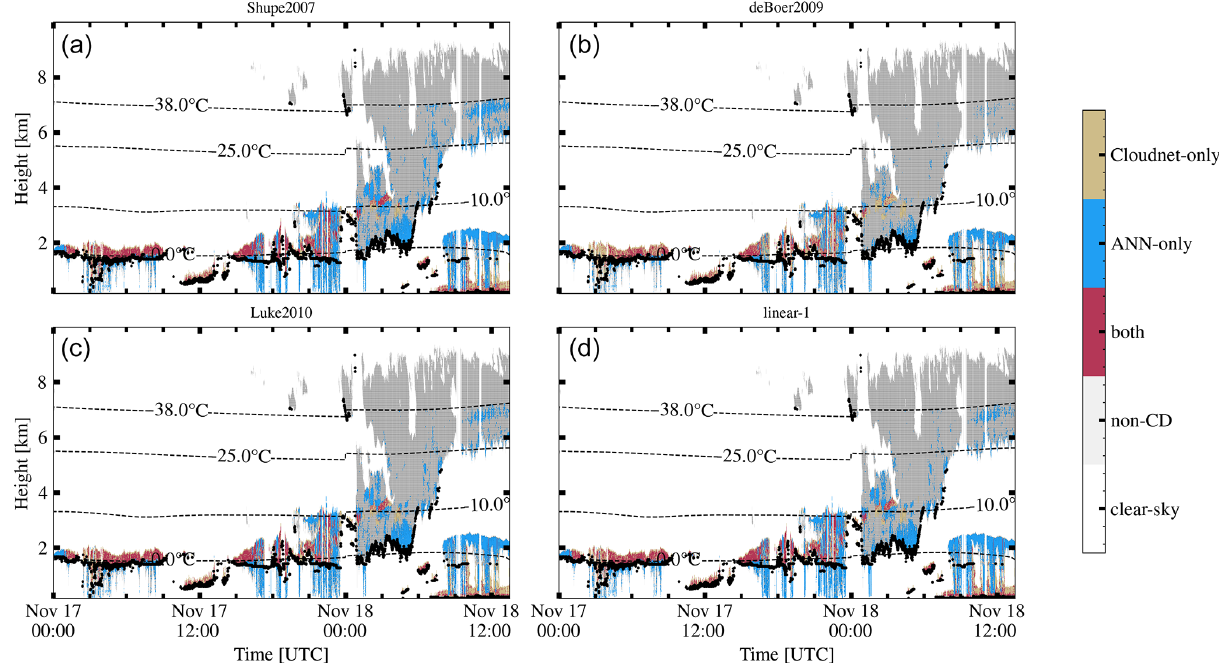
Figure 3. Sensitivity study of liquid pixel classifications of the 17–18 November 2014 case study using liquid mask thresholds of Shupe2007 (a) , deBoer2009 (b) , Luke2010 (c) , and linear-1 (d) on the ANN-predicted lidar variables. Light brown: Cloudnet-only liq- uid classifications, blue: ANN-predicted pixels using the given thresholds which were not classified as liquid droplets by Cloudnet, red: pixels classified as liquid by the ANN and Cloudnet, grey shading: pixels for which neither Cloudnet nor the ANN classified cloud droplets, black dots: ceilometer first cloud base height, and white: clear